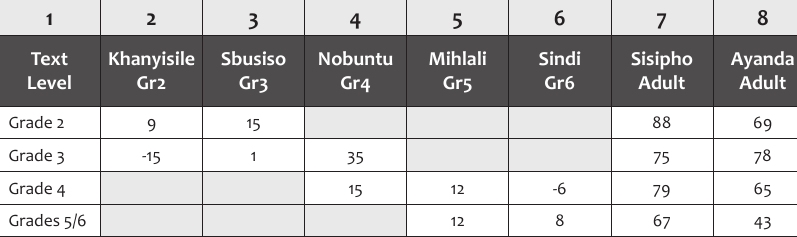
Table 7: Young Readers and Adult Readers isiXhosa Reading